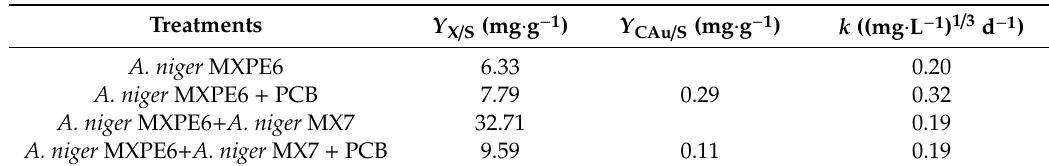
Table 1. Coefficients of fungal biomass yield ( Y X/S ), gold bioleaching ( Y CAu/S ), and fungal growth rate ( k ) per glucose consumed, for two strains of Aspergillus niger cultured in liquid media with or without printed circuit boards (PCBs) of cell phones under non-stirring conditions, after 32 days.